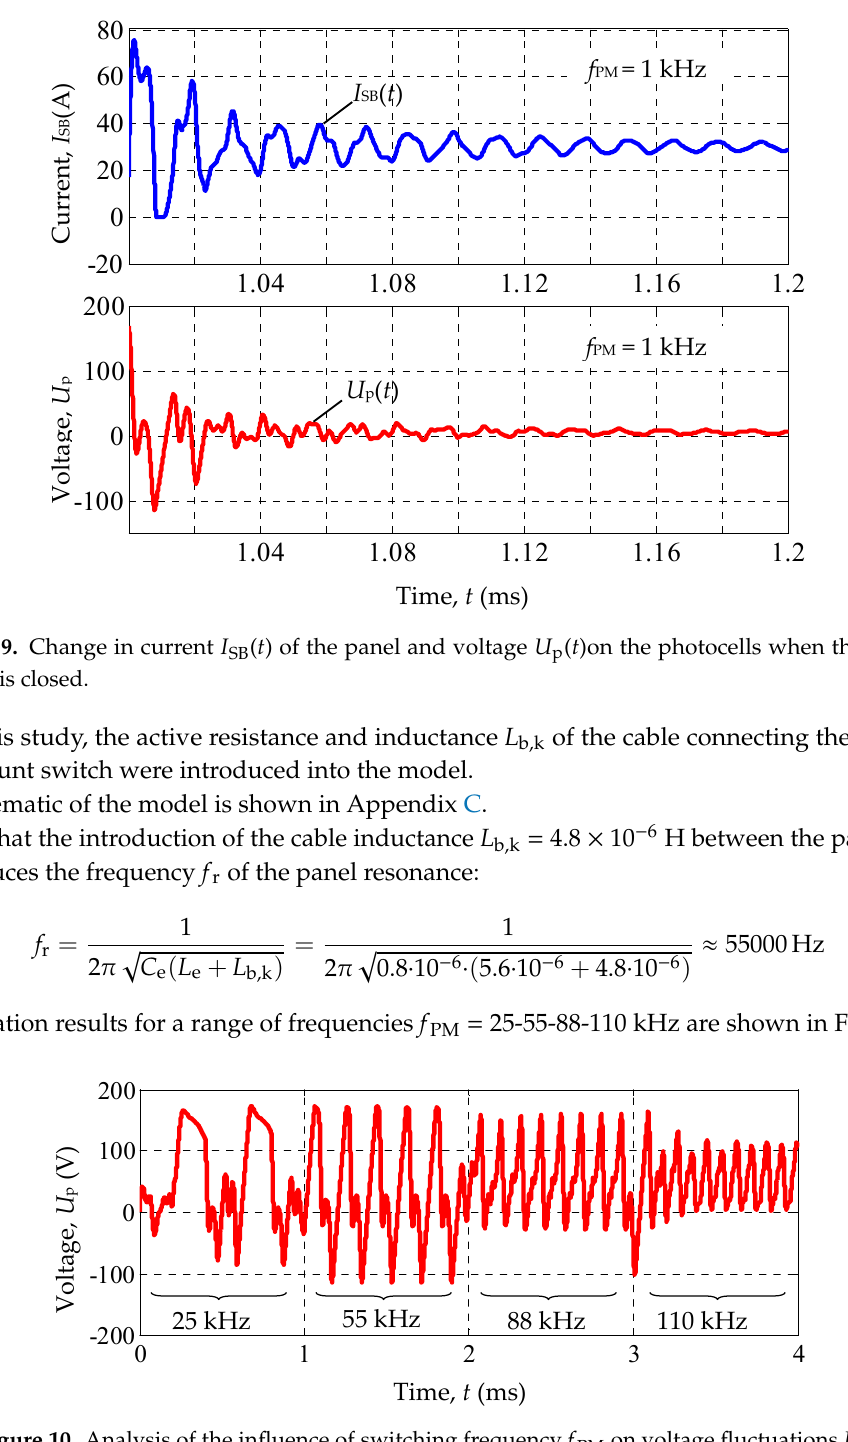
Figure 10. Analysis of the influence of switching frequency f PM on voltage fluctuations U p .